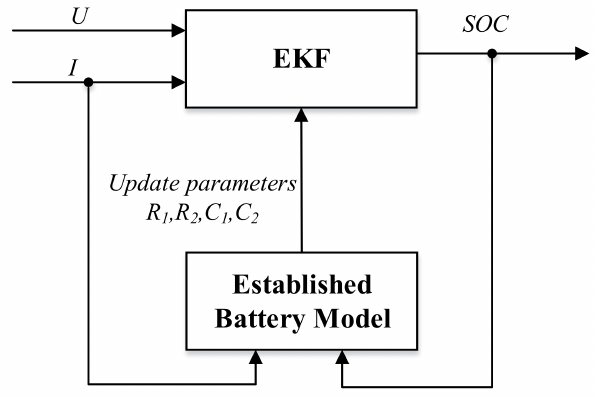
Figure 10. The structure of the SOC estimation